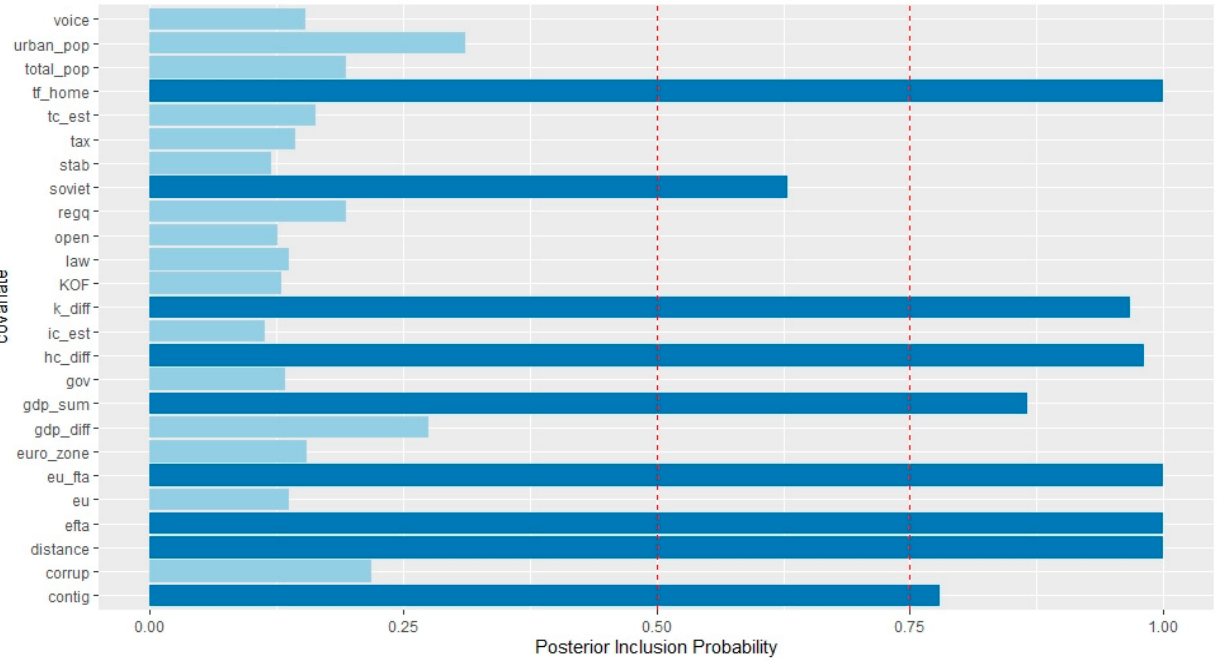
Figure 2. Inclusion probabilities for each of the potential covariates for Estonia, restricted case (2004–2017). Overall, the results find strong support for H 1 , H 2 , and H 3 . In sum, foreign MNEs primarily engage in vertical-type FDI in the Baltics, due to the existing cost differences in skilled labor (primary), and differences in physical capital (secondary). The averaged posterior coefficients on the endowment covariates largely displayed positive signs, further confirming the notion that the endowment differences generate inward FDI across the Baltics. Second, we observe that variables related to market access (trade freedom of parent country, the EU/EFTA membership) are important in driving horizontal-type FDI across the Baltics. The estimated average posterior coefficients displayed positive signs, indicating that parent barriers generate “tariff-jumping” horizontal FDI originating from non-EU/EFTA members, and the clearly significant role of the EU/EFTA members in generating foreign equity across the Baltics. Lastly, the presence of round-trip partners leads to a more pronounced horizontal motive in the general case results for Estonia, Latvia, and Lithuania. This is confirmed by the fact that the averaged posterior coefficient on